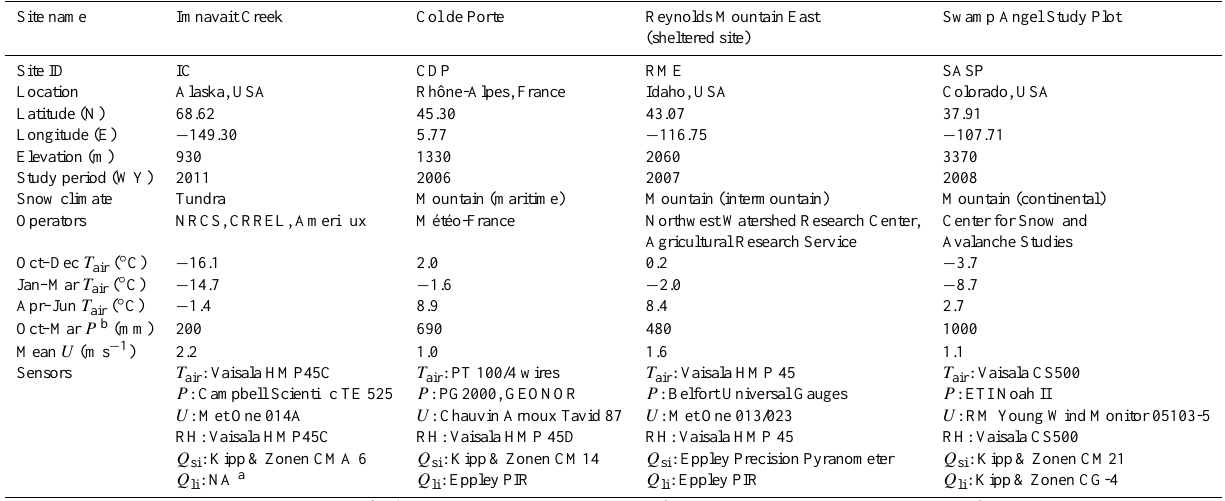
Table 1. Basic characteristics of the snow study sites, ordered from left to right by increasing elevation. Site